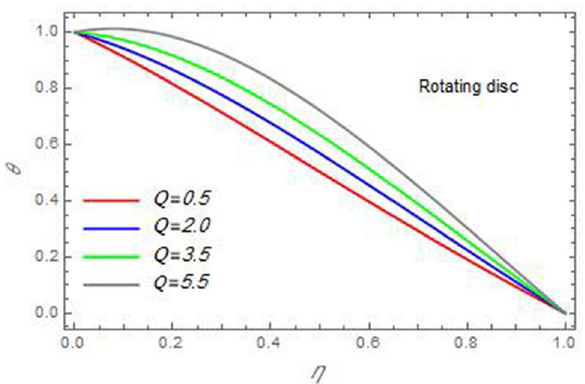
Figure 22. The temperature distribution θ is plotted versus the axial variable η in the case of stationary cone to depict the effect of the heat source parameter Q .